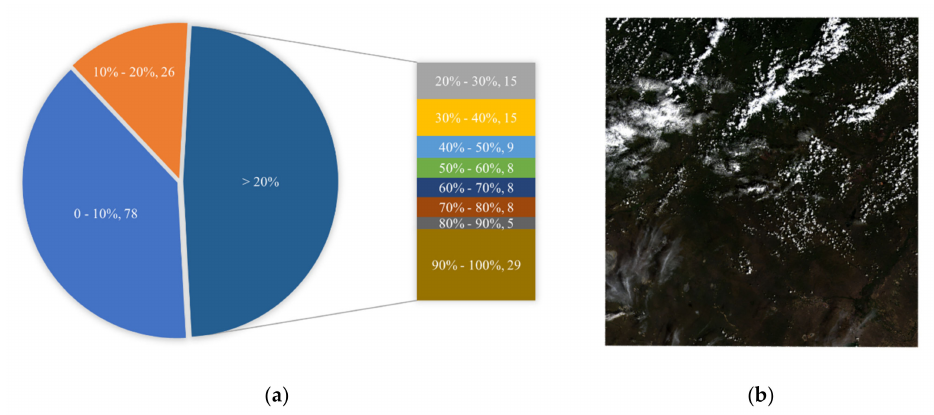
Figure 1. Landsat8 OLI data cloud coverage statistics (48 ◦ 25 (cid:48) N, 116 ◦ 49 (cid:48) E–50 ◦ 03 (cid:48) N, 118 ◦ 50 (cid:48) E, 2020) obtained using the USGS EarthExplorer system; ( a ) distribution of scenes with different cloud coverage, labeled in the format of “cloud coverage, number”; ( b ) example of a scene in our study area with slightly heavy